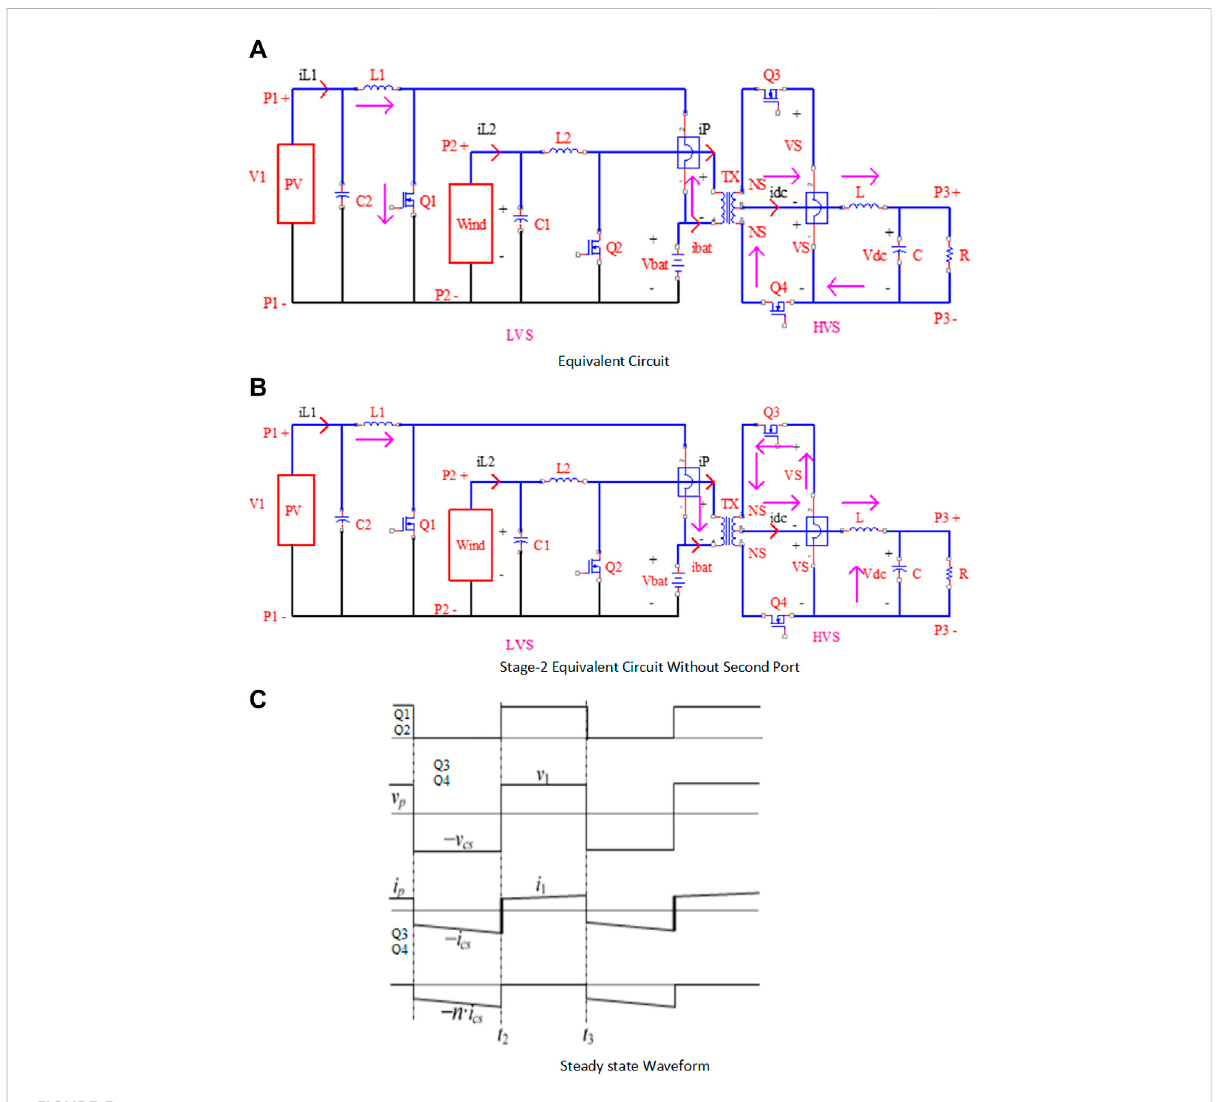
FIGURE 5 The proposed converter ’ s study in stage-1